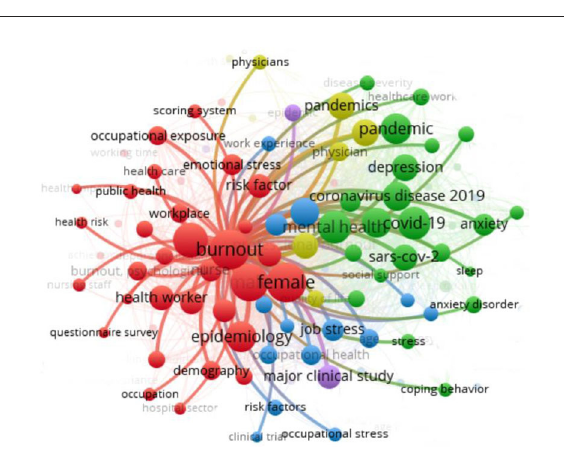
FIGURE5 Visualization of the correlation between burnout and health